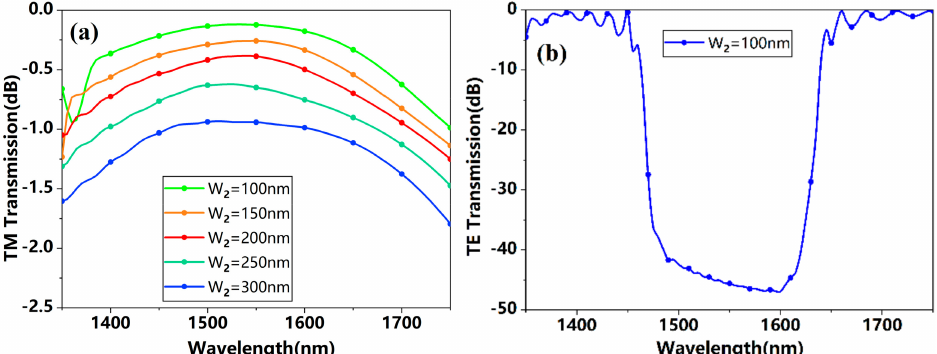
Figure 3. ( a ) The wavelength dependent transmittance of TM polarization state under various different slot width W 2 from 100 nm to 300 nm; ( b ) The wavelength dependent transmittance of TE polarization state under W 2 = 100 nm.